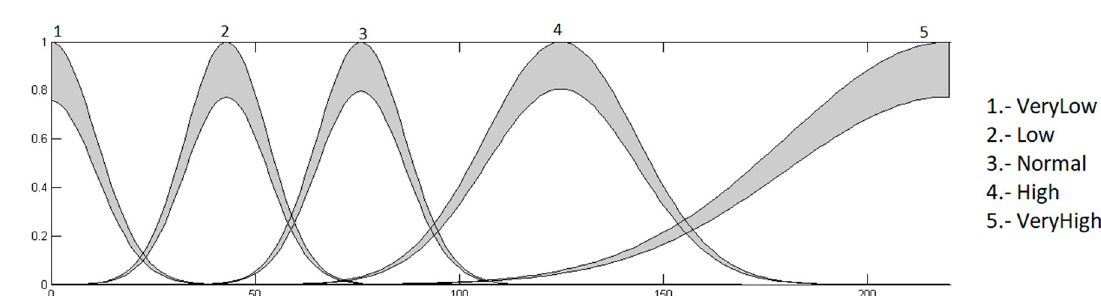
Figure 16. Input heart rate with Gaussian MFs.